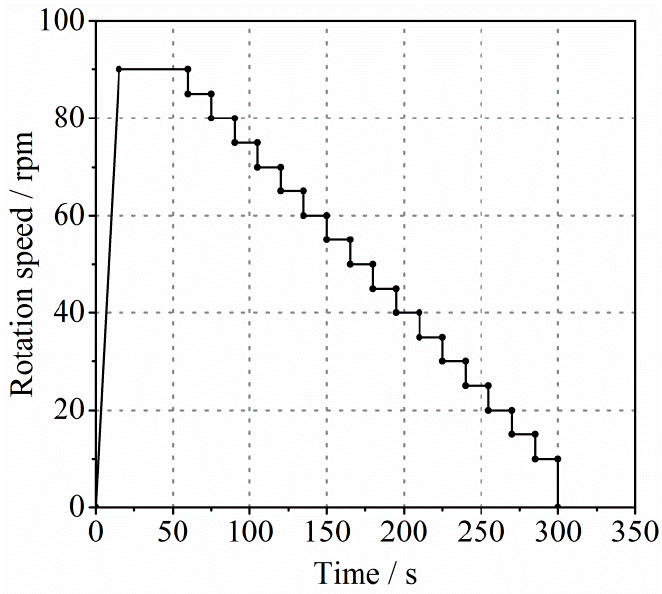
Figure 1. The testing scheme for measuring rheological parameters of mortar.